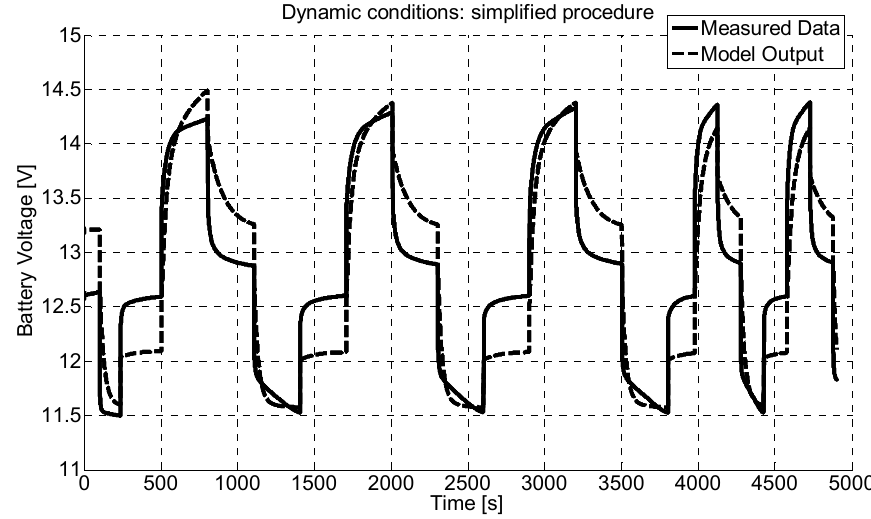
Figure 9. Test in dynamic conditions: measured battery voltage and model output with parameters from simplified procedure.